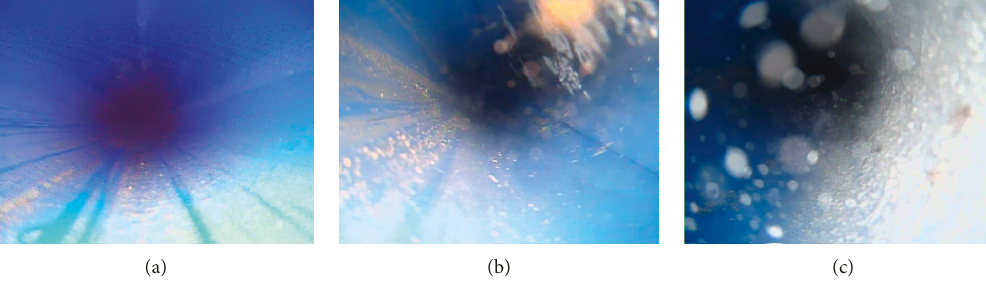
Figure 10: Hydrophobic antistatic self-cleaning coated pipe. (a) October 28, 2016. (b) January 28, 2017. (c) April 28, 2017.